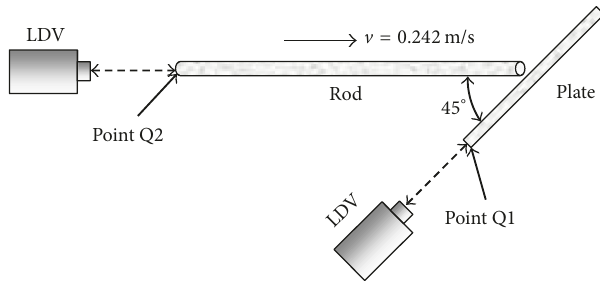
Figure 11: Vertical view of the oblique impact